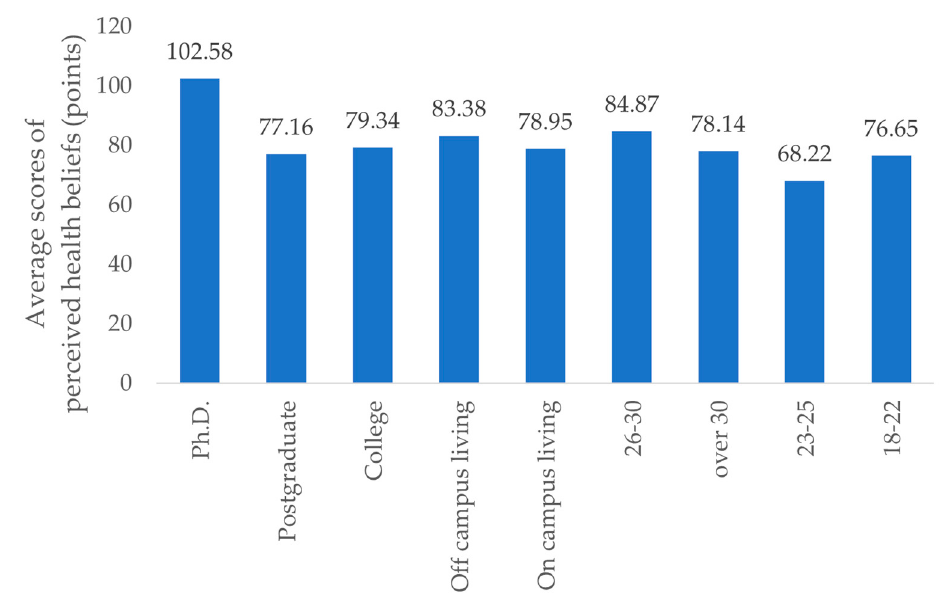
Figure 1. The average scores of perceived health beliefs for each group.